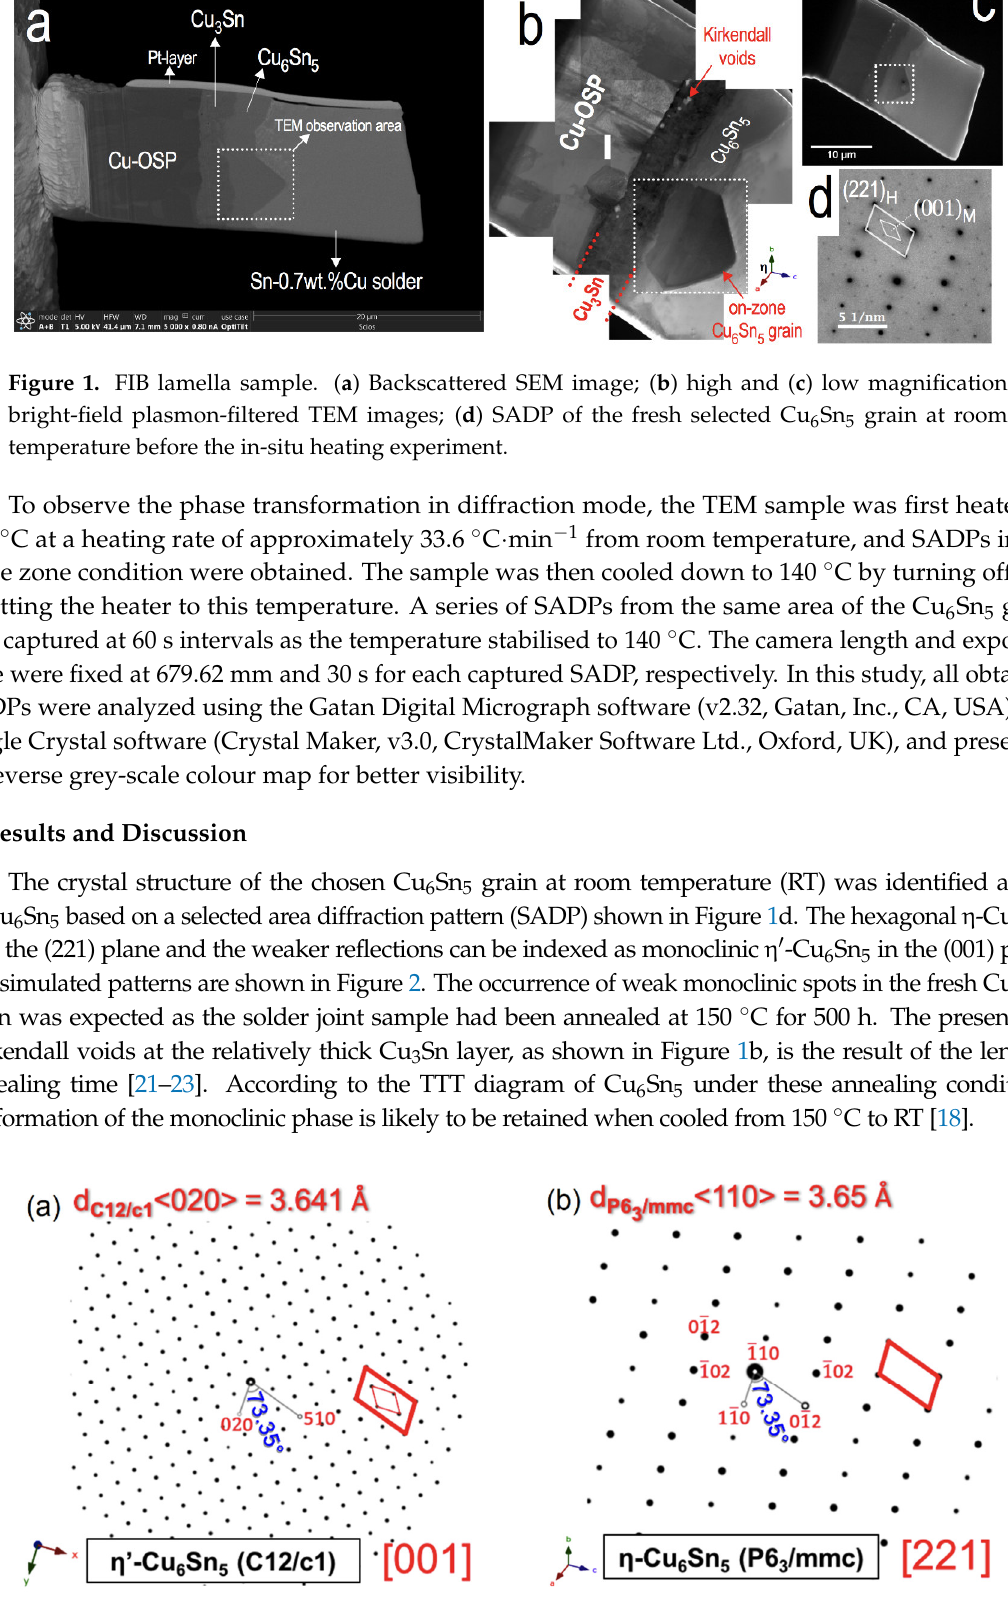
Figure 2. Simulated electron diffraction patterns of the ( a ) monoclinic η′-Cu 6 Sn 5 C12/c1 structure and ( b ) hexagonal η-Cu 6 Sn 5 P6 3 /mmc structure corresponding to the obtained SADPs in this study.